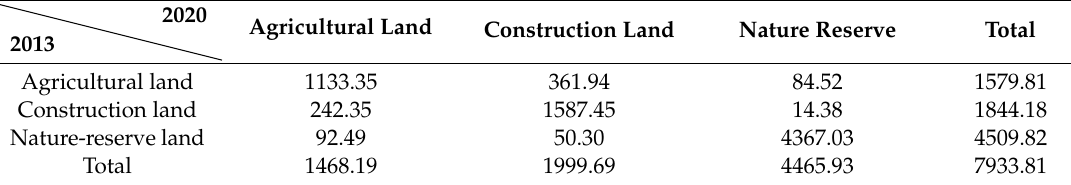
Table 10. The 2013–2020 area transition matrix (unit: km 2